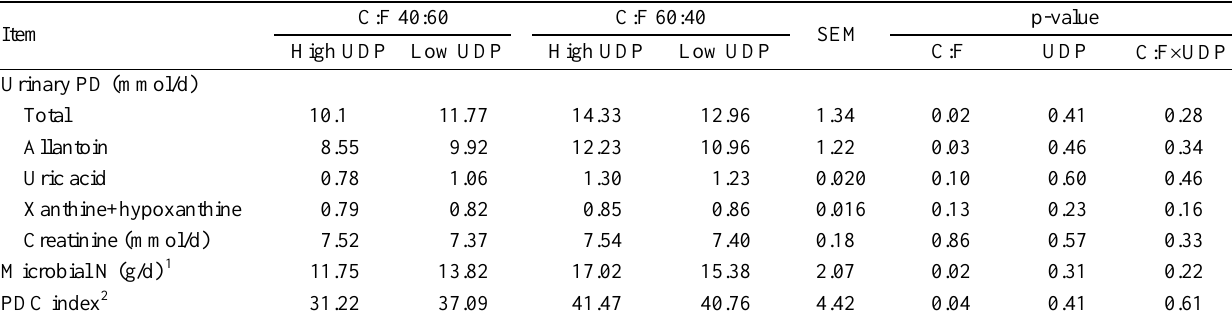
Table 3. Urinary purine derivatives, creatinine, and PDC index in total urine and microbial N in lambs